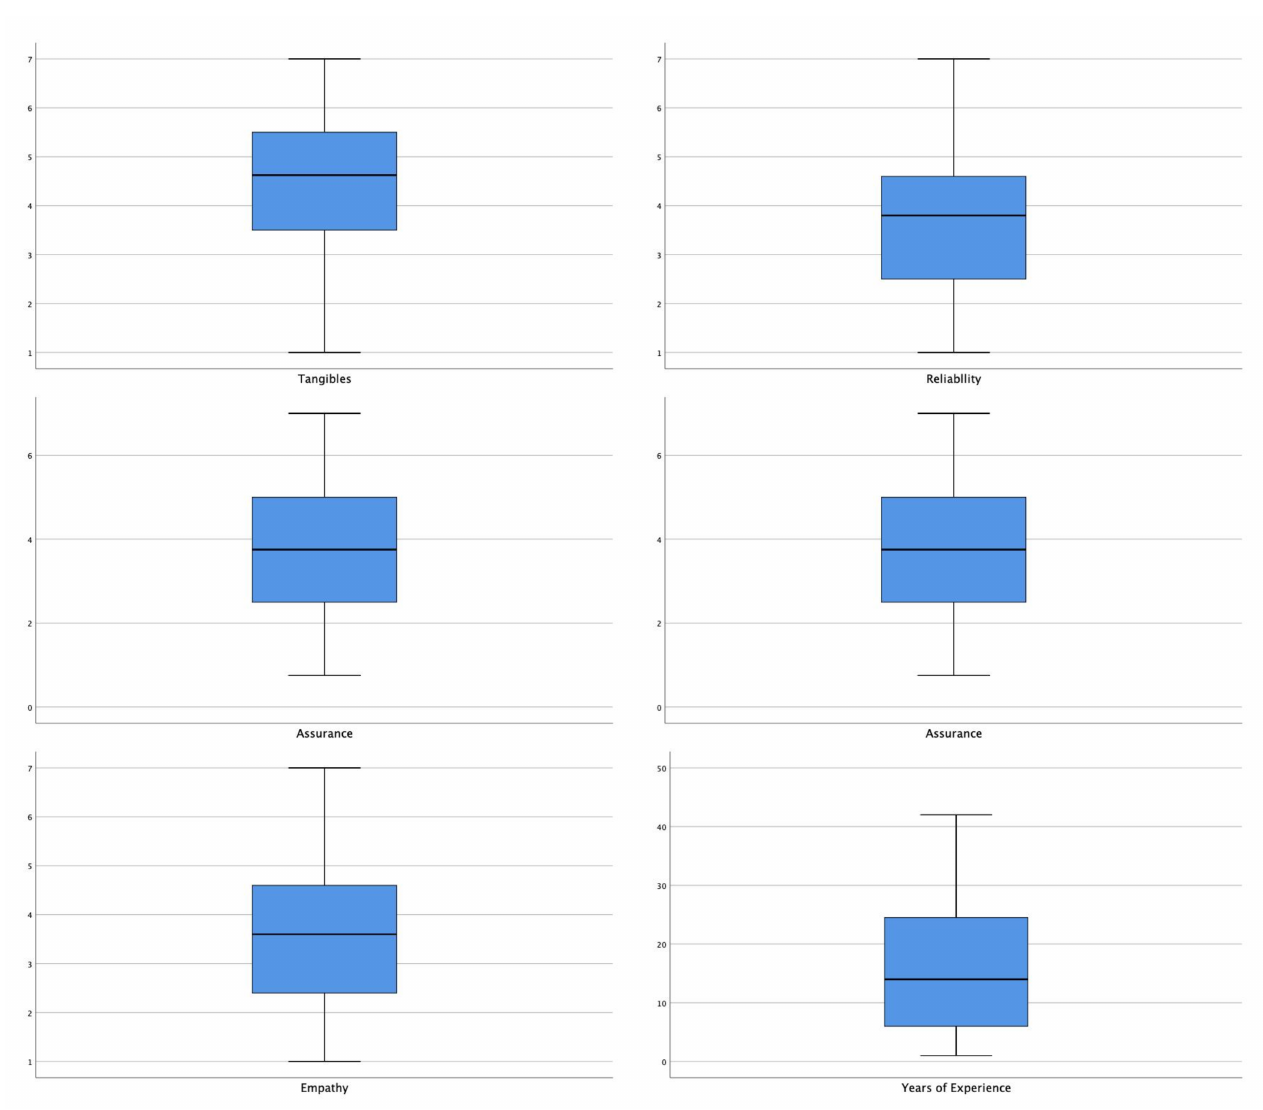
Figure 1. The boxplots of Years of Experience and the Quality dimensions. In the above boxplot (the boxplots are also called box and whisker plots), the horizontal lines within each box represent the median, the lower end of each box is the 1st quartile, the upper end of each box is the 3rd quartile, the boundary of the lowest whisker is the minimum value of the dataset, and the boundary of the highest whisker is the maximum value of the data